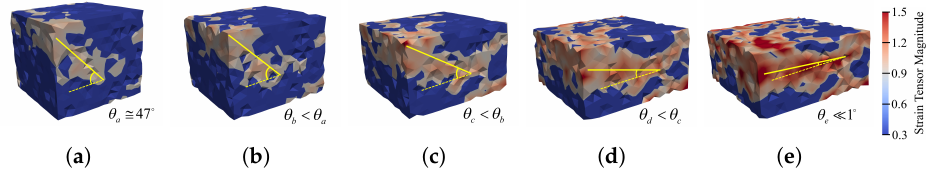
Figure 9. The micro-strain contour evolution during the compaction process of specimen S 1 , ( a ) (cid:101) 3 = 0.1, ( b ) (cid:101) 3 = 0.2, ( c ) (cid:101) 3 = 0.3, ( d ) (cid:101) 3 = 0.4, ( e ) (cid:101) 3 = 0.5.